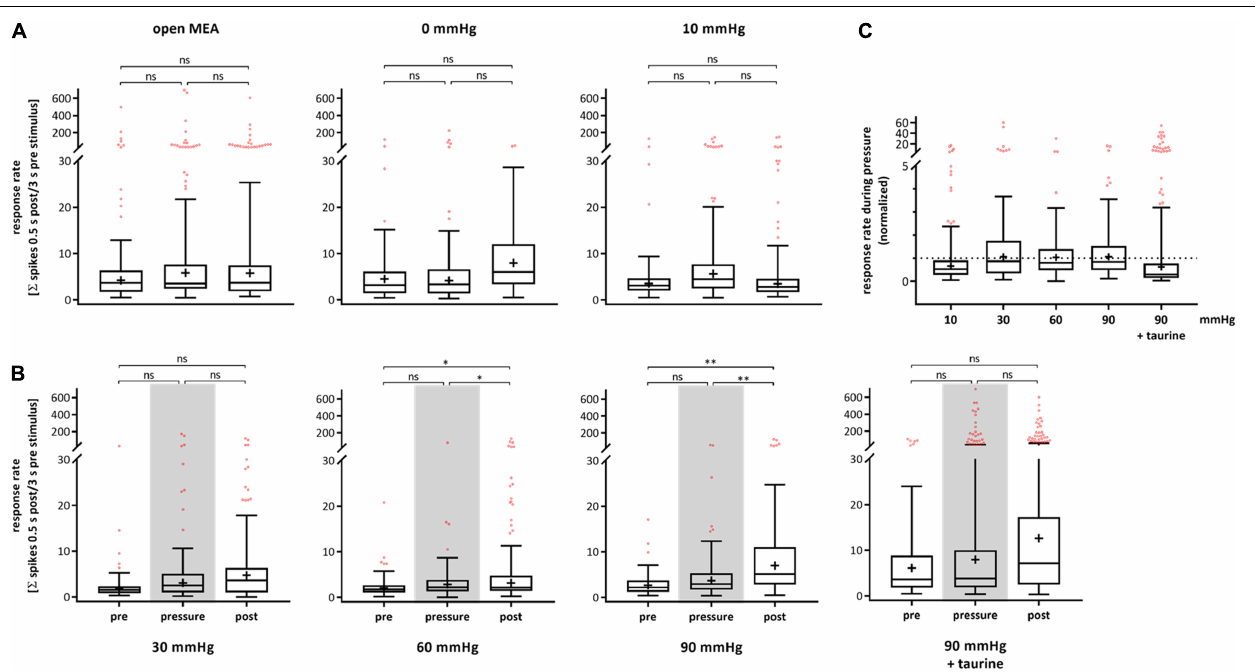
FIGURE 3 | Response rate of RGCs after electrical stimulation under different pressure levels. The RGC response to electrical stimulation ( ± 80 µ A, 500 µ s per phase) before (pre), during (pressure), and after (post) pressure stress is shown. The response rate was defined by the coefficient of the number of spikes 0.5 s after stimulation and 3 s before stimulation. (A) The results of the control experiments without pressure lid (open MEA), 0 mmHg, and 10 mmHg are presented. (B) The results of the test groups with 30, 60, 90 mmHg, and 90 mmHg + taurine (1 mM) are presented. (C) Summary of the normalized RGC response rate during pressure is shown. The response rate before pressure (pre) was set to 1. Data are presented as box and whisker (min to max) plots. Outliers calculated by ROUT ( Q = 0.1%) are shown as red circles. Mean values of the cleaned data are shown as + . Significant values are indicated by asterisks. Not significant values are labeled with ns in panels (A,B) and not labeled in panel (C) . One-way ANOVA with post hoc Tukey’s test was performed with GraphPad Prism Software version 7. (A) F (2, 387) = 0.0403, p = 0.9605; F (2, 160) = 0.4285, p = 0.6522; F (2, 187) = 0.5299, p = 0.5896; (B) F (2, 224) = 2.654, p = 0.0726; F (2, 278) = 4.854, p = 0.0085; F (2, 240) = 2.257, p = 0.1069; F (2, 482) = 2.155, p = 0.1170; (C) F (4, 531) = 2.206, p = 0.0671. n retinae = 5/group, n cells = 47–118/group, n recordings =